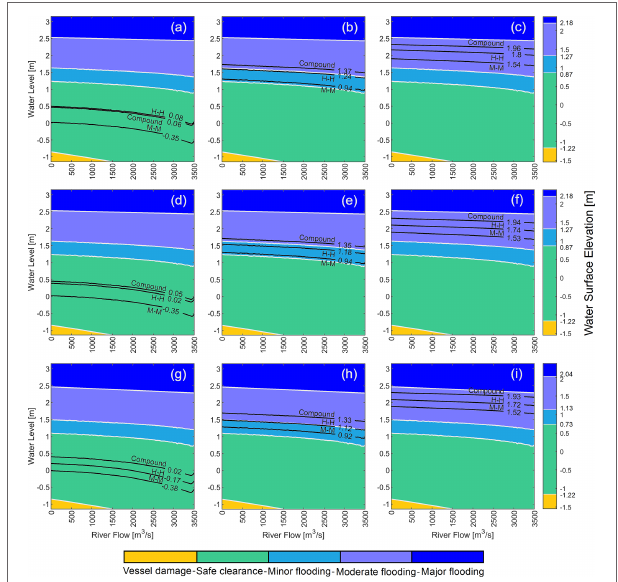
FIGURE 5 | Mean water surface elevation (WSE) as a function of upstream and downstream forcing conditions and dredging protocols. Black contour lines represent WSE obtained from M-M (baseline), H-H, and CF scenarios at selected control stations in the Mobile Bay channel: A2 (A–C) , A3 (D–F) , and A11 (G–I) . Gray lines represent threshold values for safe navigation and hazard zones (color bar). Left, middle, and right panels show WSE simulated with current mean sea level, and sea level rise projections under RCP 4.5 (50 th percentile), and RCP 8.5 (50 th percentile),